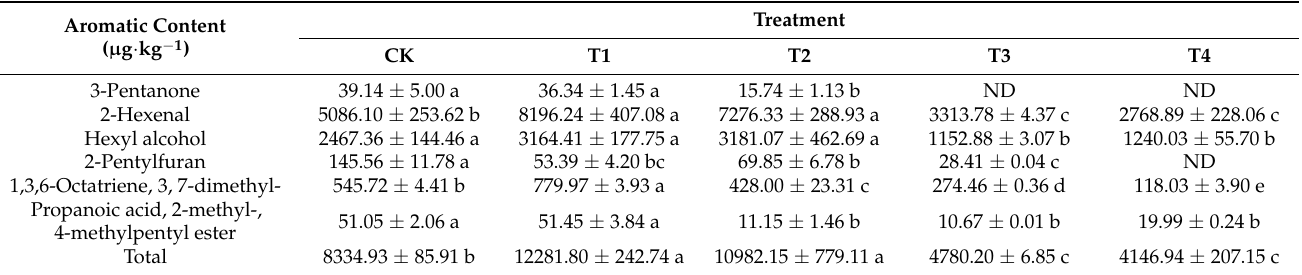
Figure 6. Random forest model for 24 aromatic substances. The A–X in the figure represents aromatic substances. The detailed data are shown in Supplementary Table S1. The size of the horizontal axis represented the number of mse-increase. Table 3. Effects of reduced fertiliser application before harvest on aromatic compounds in pepper